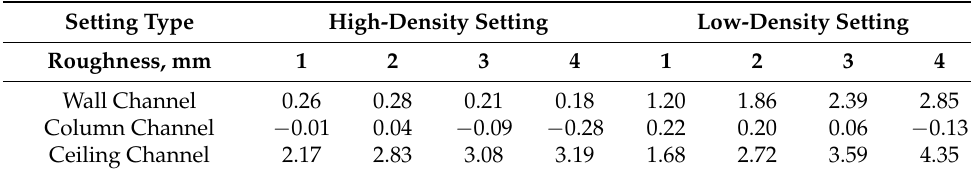
Table 6. The percentage increases in average air velocities in the different kiln channels for different brick surface roughness levels.